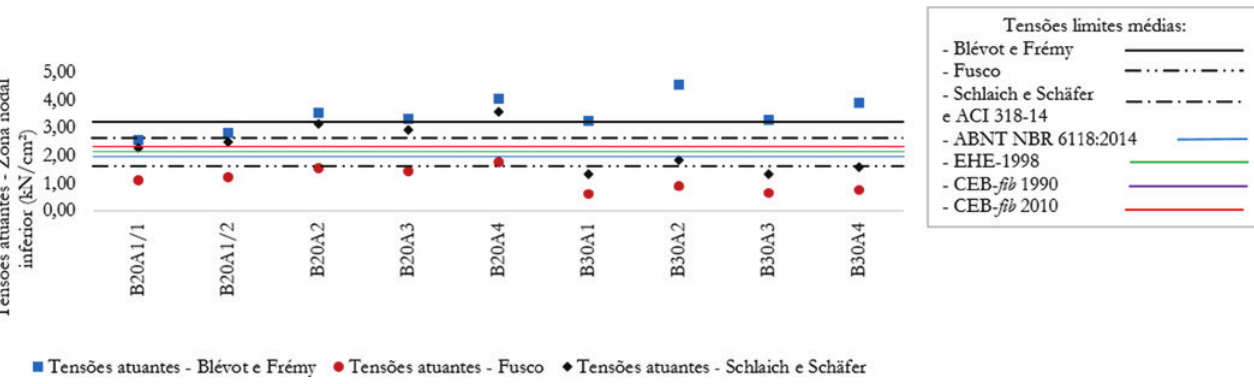
Modelos ensaiados por Miguel [8] × σ